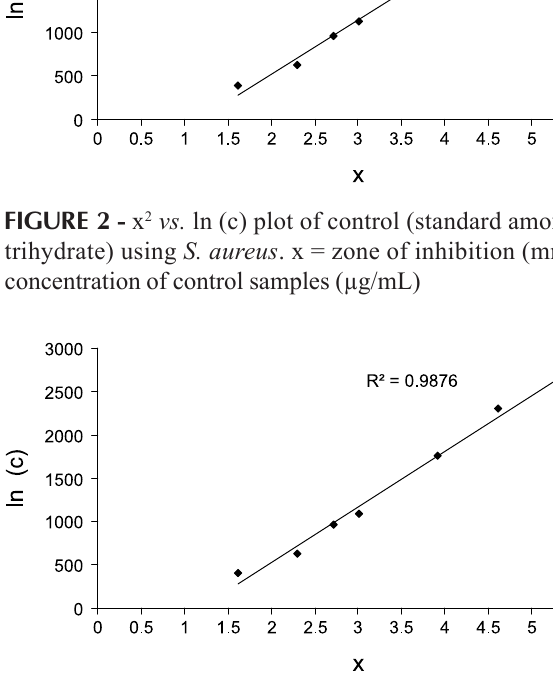
FIGURE 3 - x 2 vs. ln (c) plot of control (standard amoxicillin trihydrate) using E. coli . x = zone of inhibition (mm); c = concentration of control samples (µg/mL)